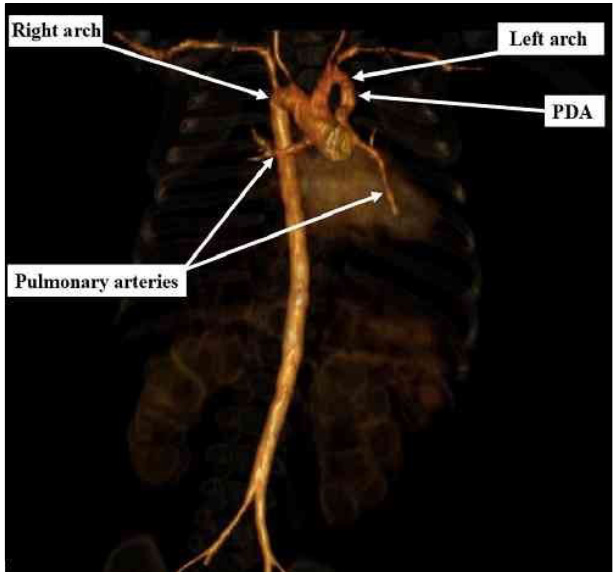
Fig. 1 – Three-dimensional reconstruction of computed tomography angiography showing both aortic arches, right and left. Note that the right arch is continuous with the descending aorta, and the left arch is interrupted right after the emergence of the ductus arteriosus which connects in the confluence of the right and left pulmonary